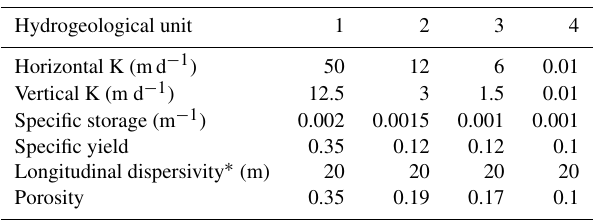
Table 2. Calibrated parameters used for the different hydrogeolog- ical